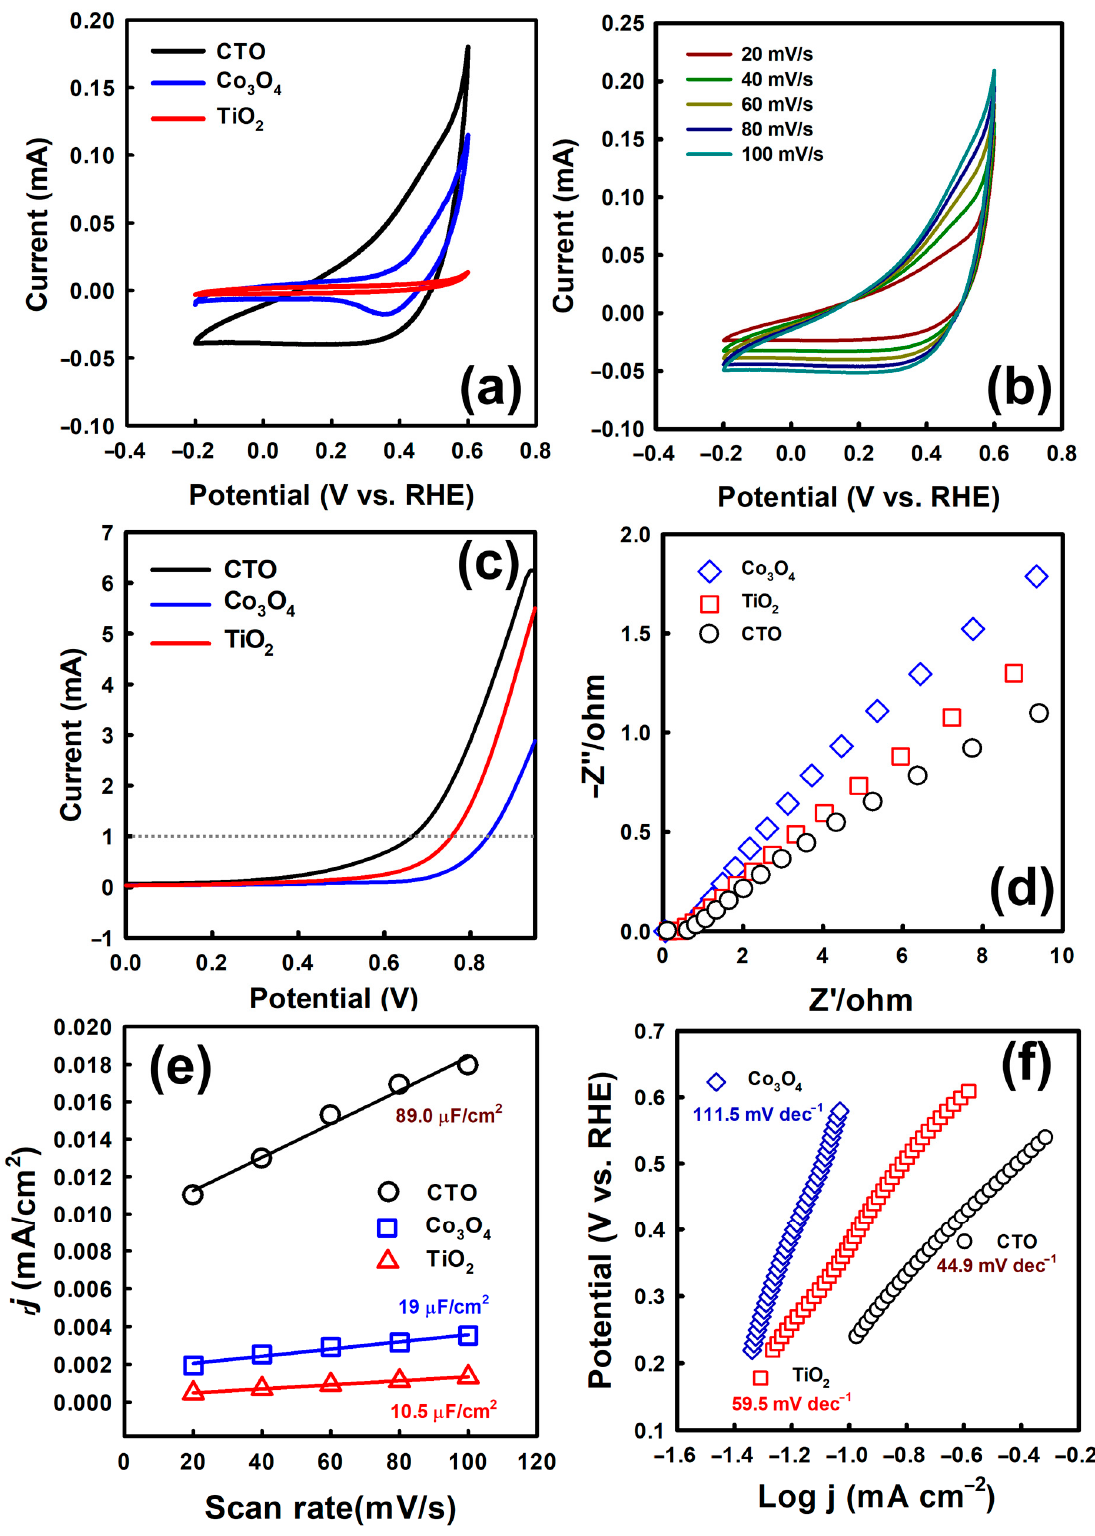
Figure 4. ( a ) CV curves of different catalysts at a scan rate of 60 mV/s, ( b ) CV curves of CTO at different scan rates, ( c ) LSV curves of different catalysts at a scan rate of 1 V/s, and ( d ) EIS Nyquist plots of different catalysts. A 1 M KOH was used as the electrolyte; ( e ) ECSA curves and ( f ) Tafel plots of CTO, TiO 2 , and Co 3 O 4 .